Question: What style of plot is this figure drawn as?
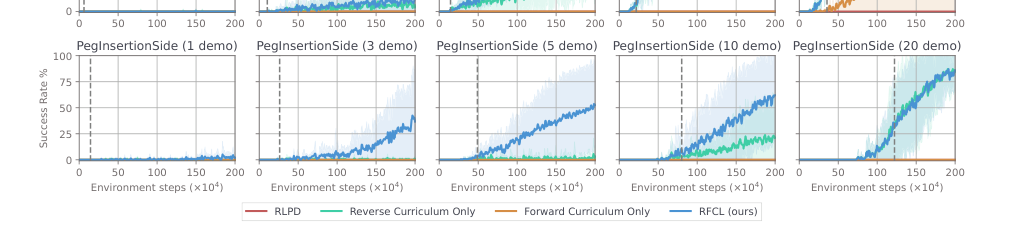
Answer: bar